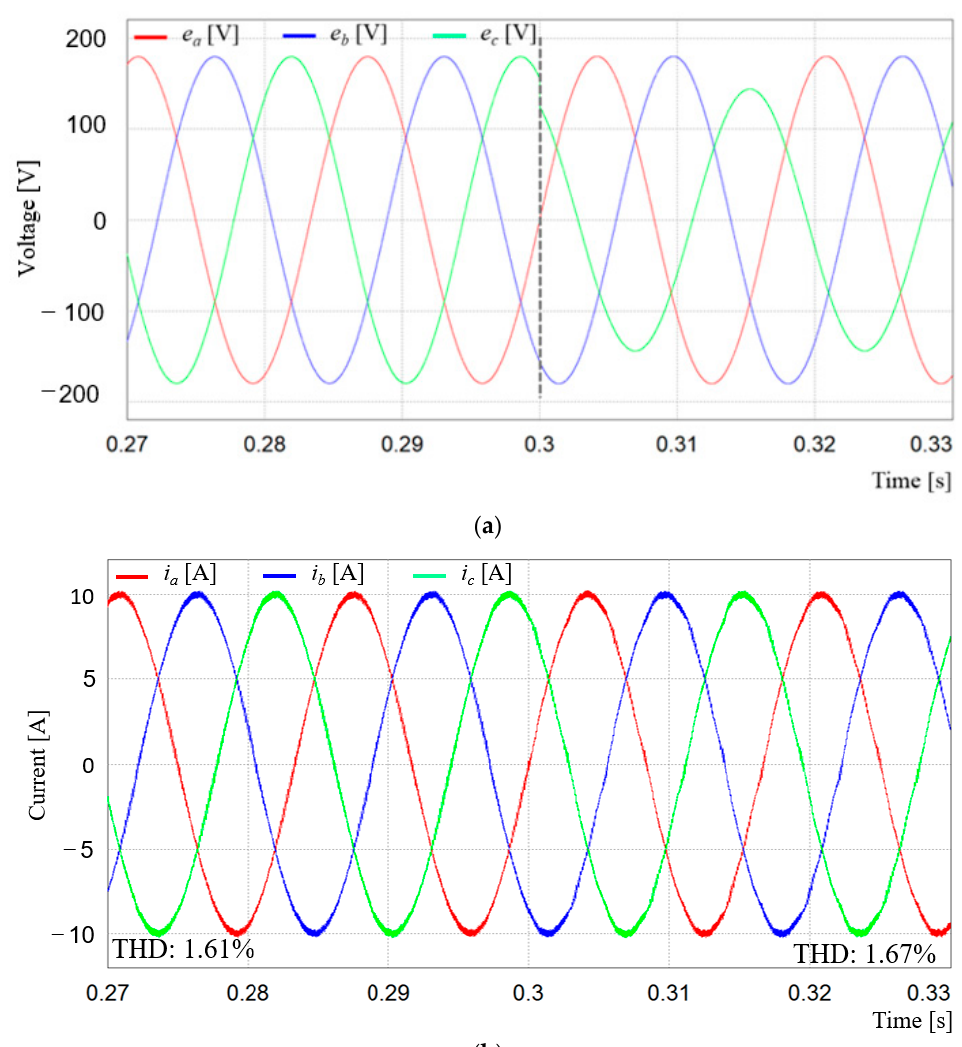
Figure 11. Transient response of the proposed FCS-MPC scheme in the presence of a sudden unbalanced grid condition. ( a ) Three-phase grid voltages; ( b ) three-phase inverter currents.